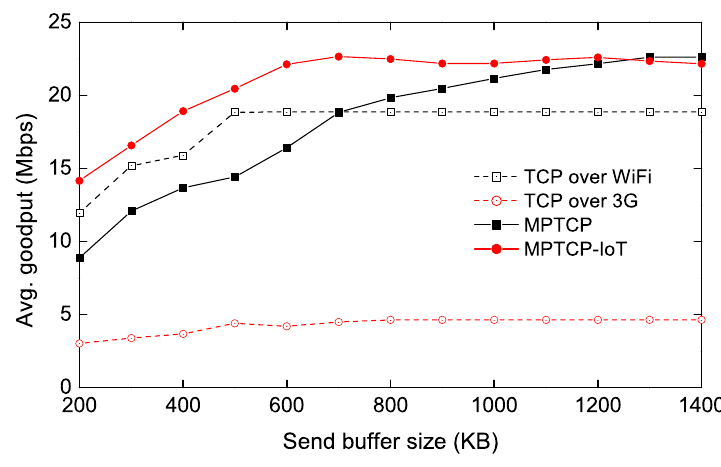
Figure 5. Throughput measurement as a function of send-buffer size of IoT device.